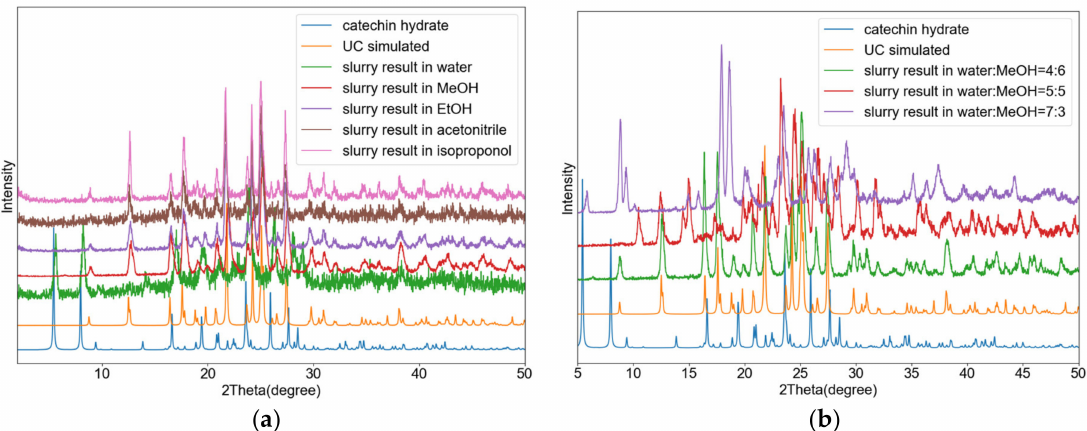
Figure 11. ( a ) PXRD profiles of congruence experiments results of UC in different solvents. ( b ) Various products obtained using different methanol/water ratio when suspending stoichiometric ratio of urea and